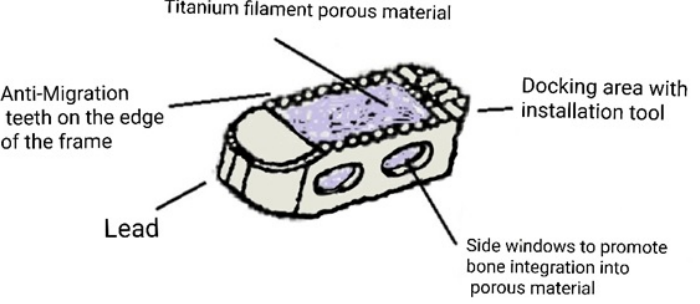
Figure 2. Schematic illustration of the simulated cage.